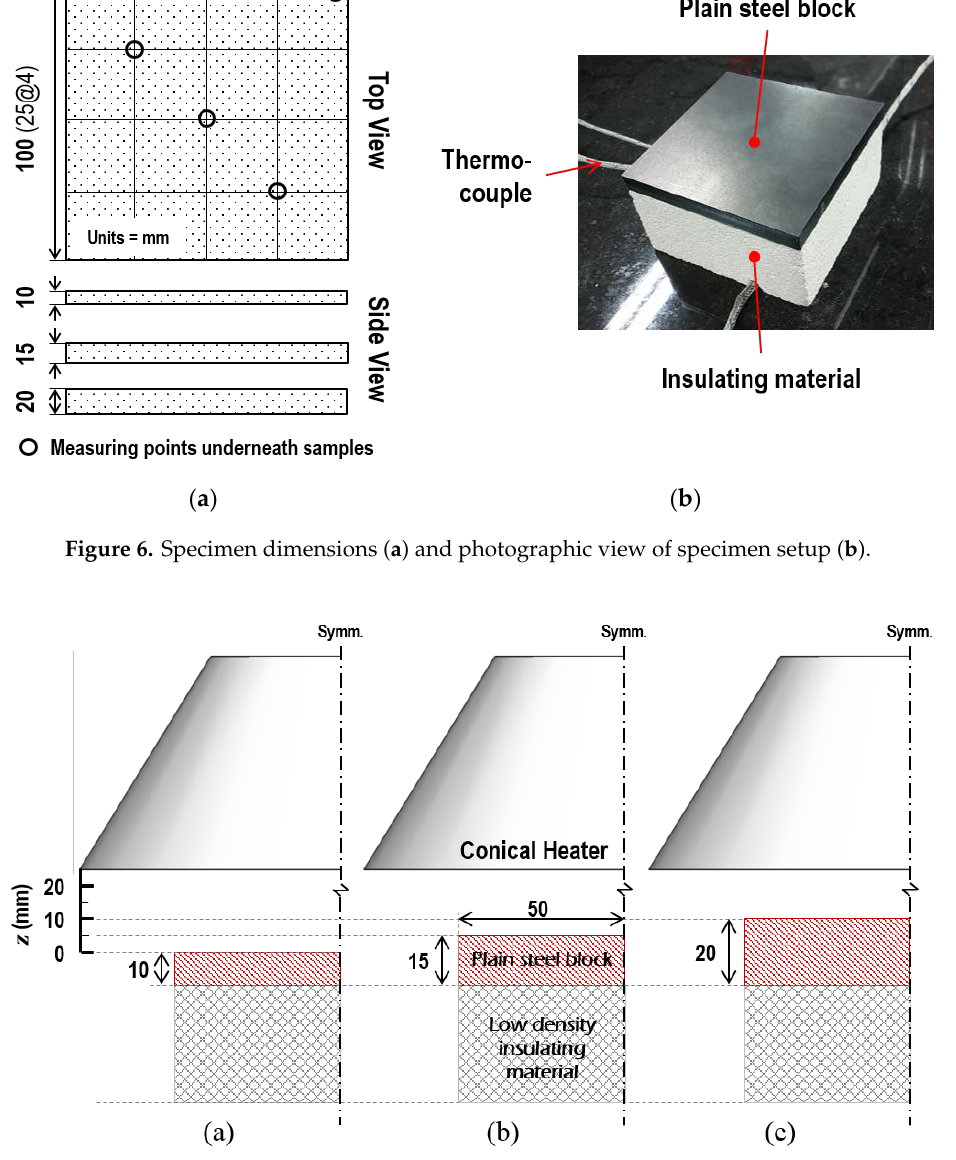
Figure 7. Test configurations in cone calorimetry tests for specimens with thicknesses ( δ ) of ( a ) 10, ( b ) 15, and ( c ) 20 mm.